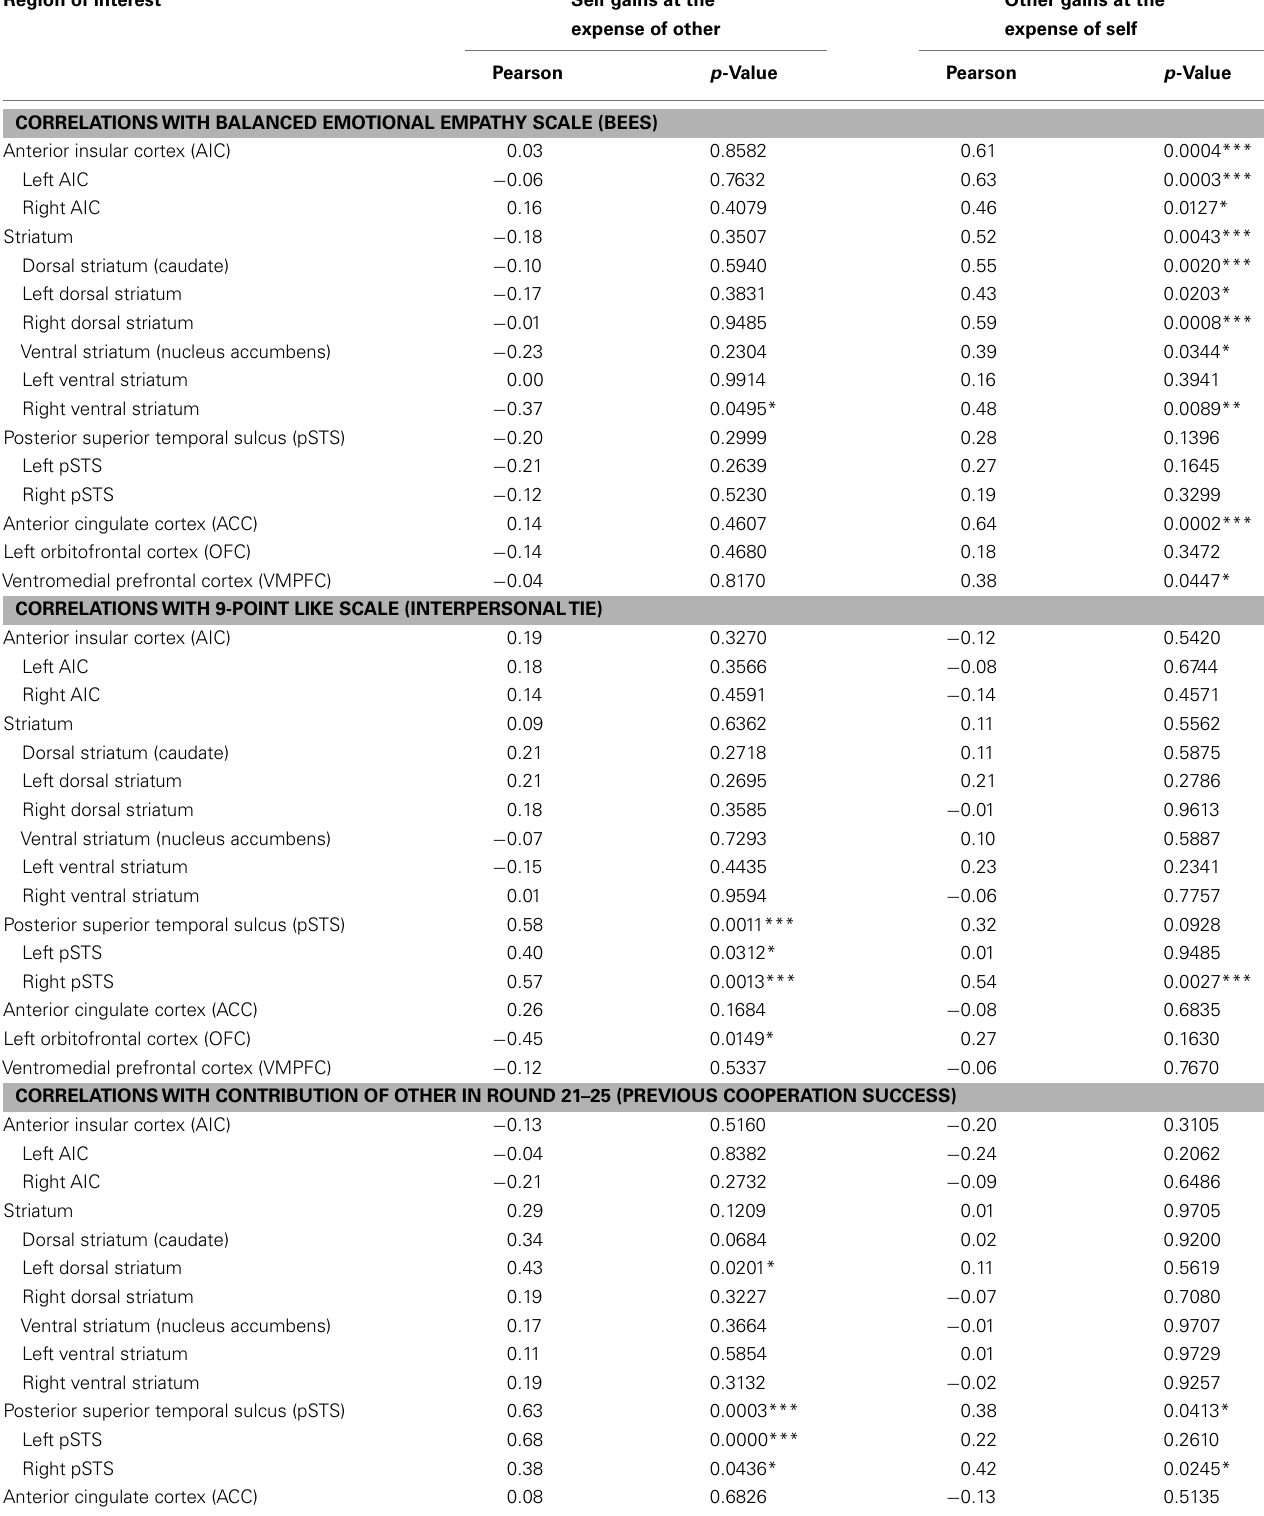
Table 4 | Correlations for sharing with measures of empathy, social ties, past cooperation success, and future investment behavior. Region of interest Self gains at the